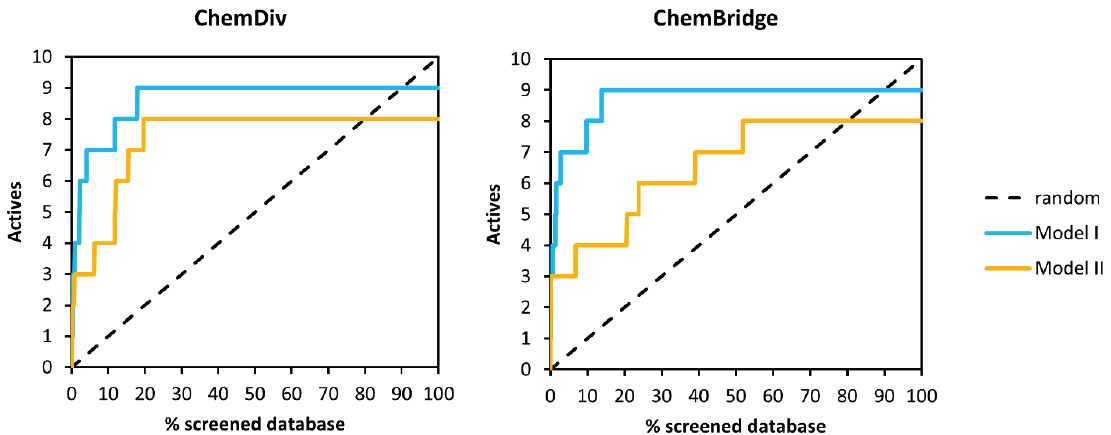
Figure 8. Enrichment curves obtained from pharmacophore searches performed on ChemDiv ( left ) and Chembridge ( right )